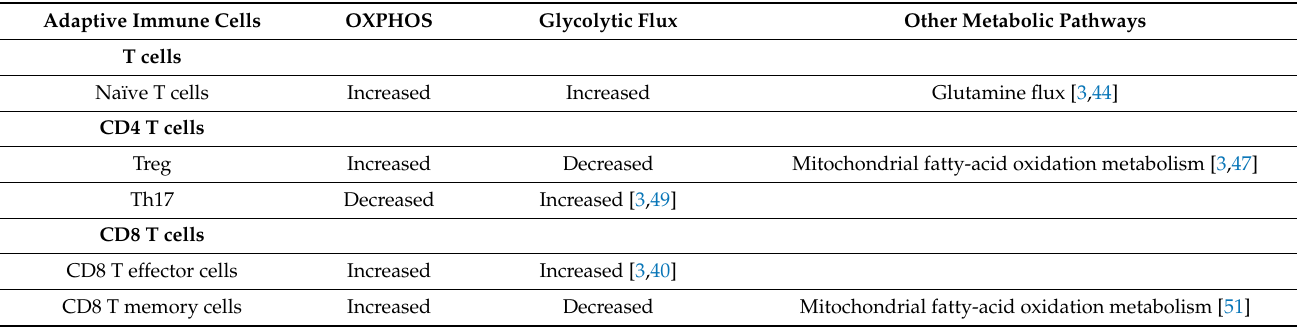
Table 2. Interplay between mitochondria and adaptive